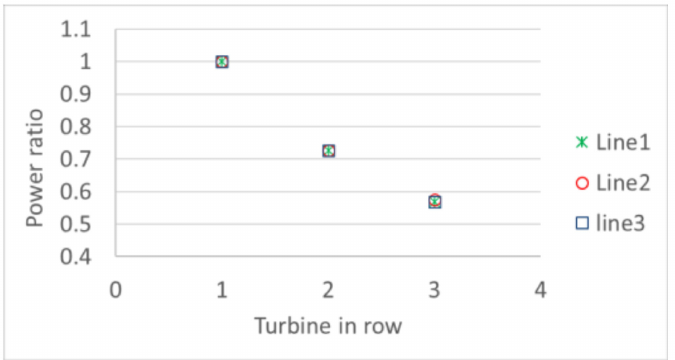
Figure 22. Power deficit in the lines: the power of each wind turbine is divided to the first turbine power in the line (turbine that is not affected by the wake).